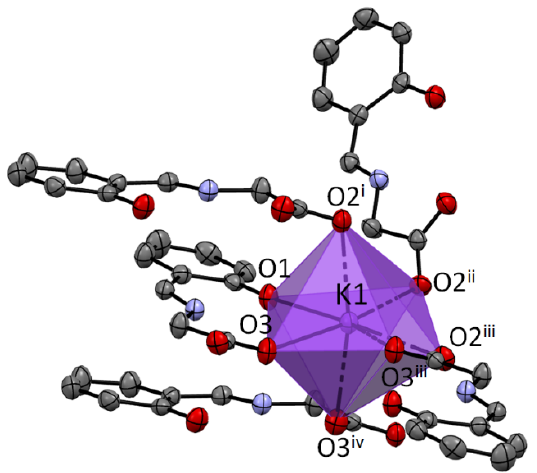
Figure 2. Packing diagram showing the seven-coordinate geometry of the K ion in 1a (i: 1 − x, y, 5 / 2 − z; ii: ½ + x, y, 2 − z; iii: 1 − x, − y, 2 − z; iv: 1 − x, y, 3 / 2 − z).